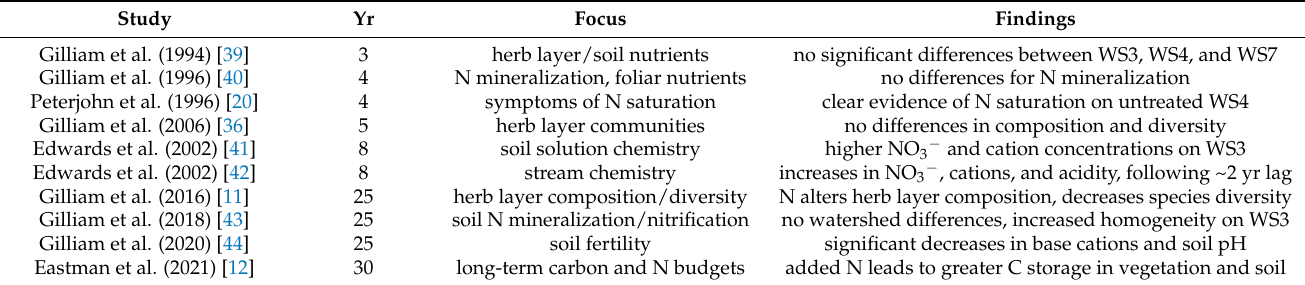
Table 1. A brief summary of 10 studies published in the peer-reviewed literature. Yr indicates the number of years of treatment on WS3 represented by latest year of sampling of a given study. Many studies were multi-focused with multiple findings. For brevity, only the principle areas of focus and findings are summarized herein.